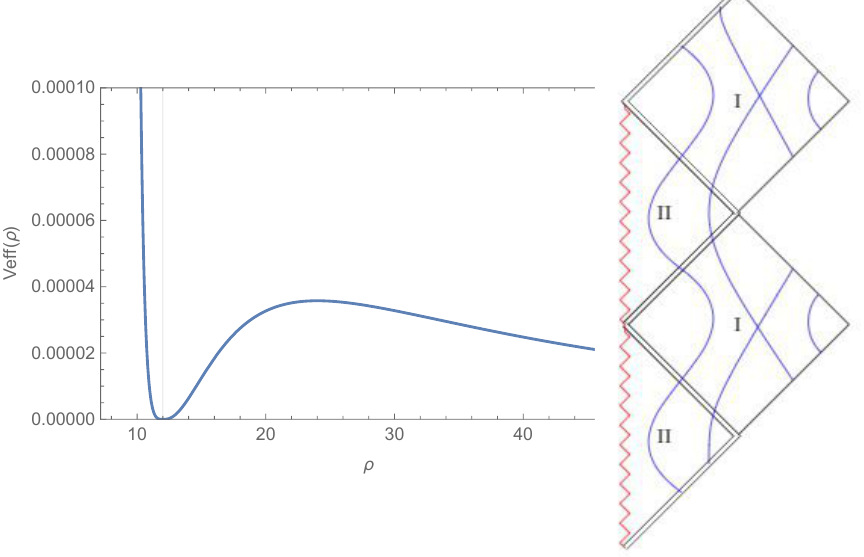
Figure 2. Plot of the effective potential for massless particles ( left figure) and the Carter–Penrose diagram ( right figure) for the first solution with a even. The vertical line indicates the event horizons. In the CPD, the red lines are the singularities, the double lines are the horizons, and the blue lines are the possible geodesic curves. Here, we used the following values for the parameters: λ = 6, k = 3, m = 10, L =